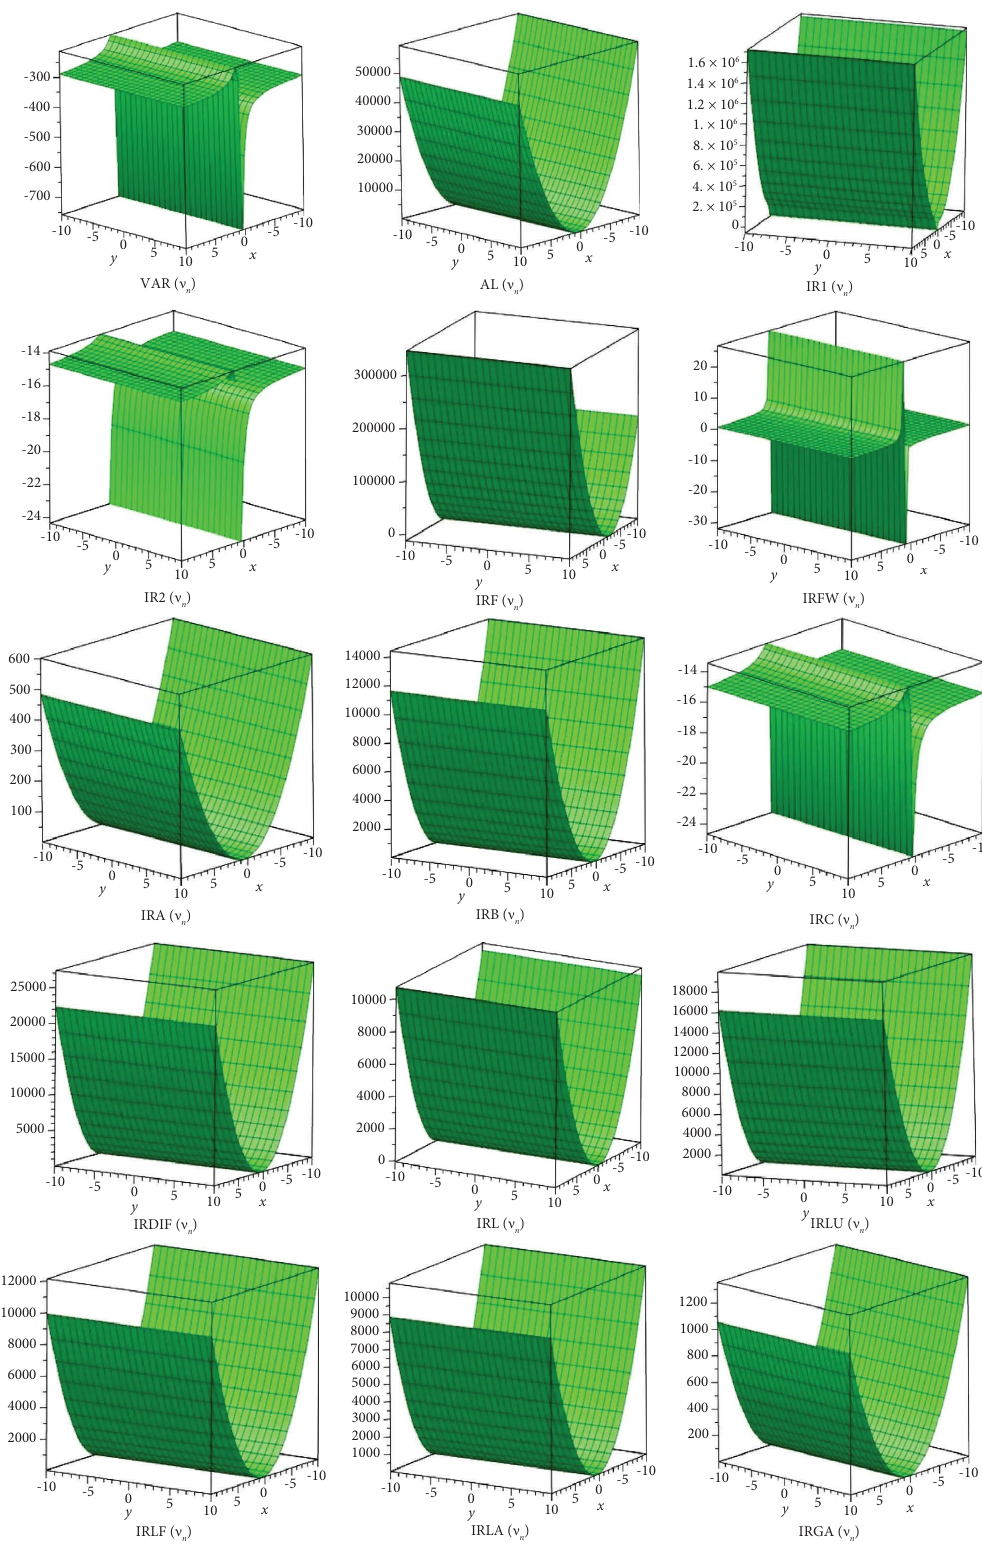
Figure 6: 3D plot for irregularity indices for ]